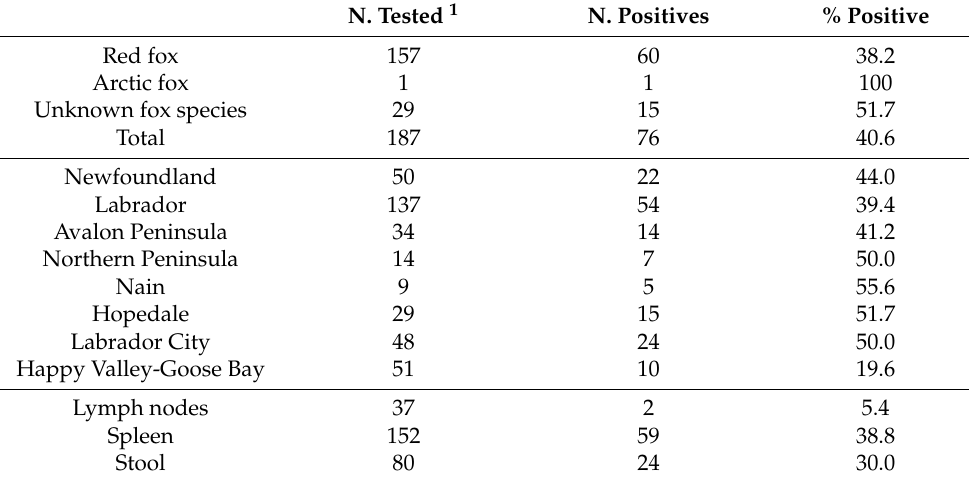
Table 2. Detection rates of Newlavirus in foxes.